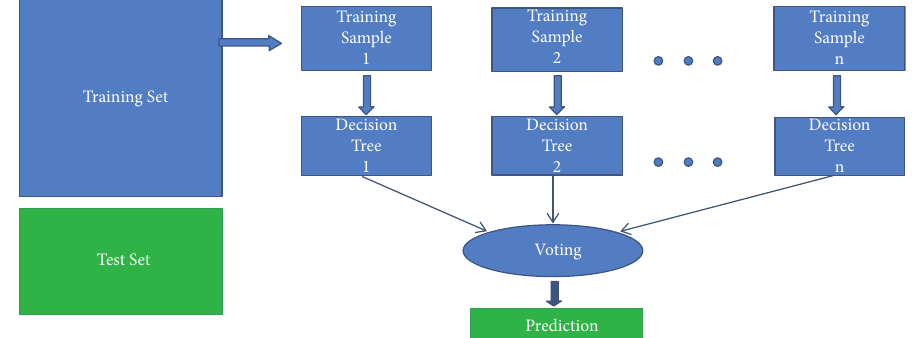
Figure 12: Random forest: https://www.datacamp.com/community/tutorials/random-forests-classifier-python.